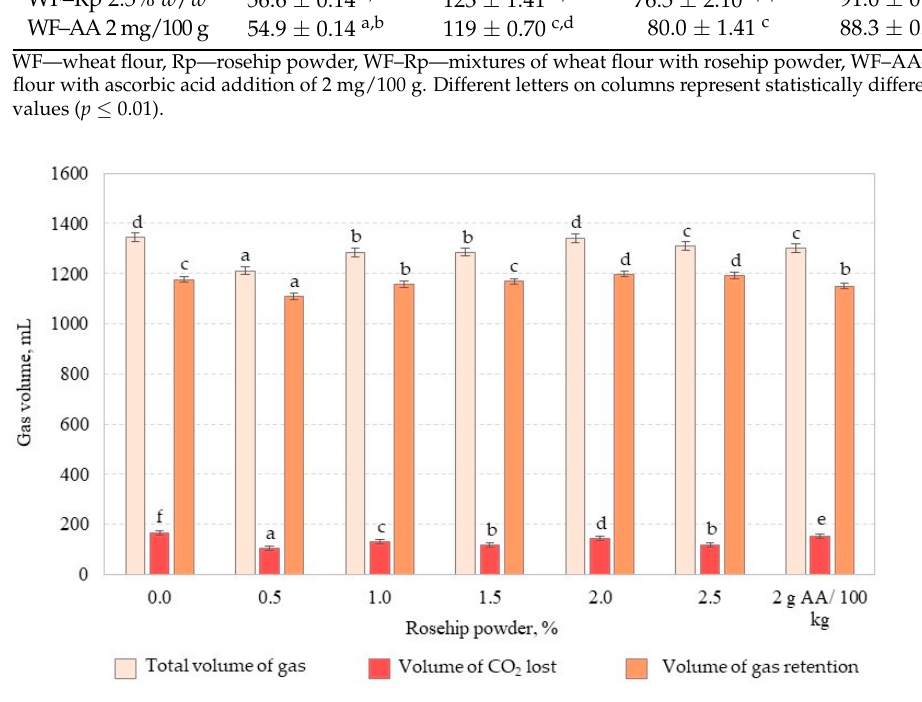
Figure 5. Gas volume as a function of Rp addition. Different lower-case letters represent statistically di ff erent mean values ( p ≤ 0.01). AA is ascorbic acid.